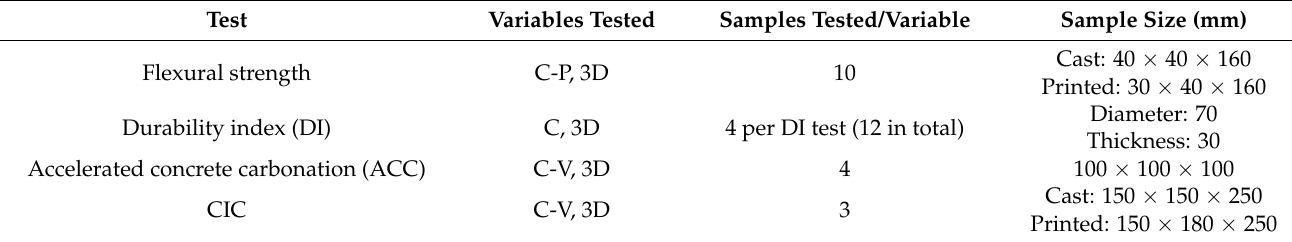
Table 1. Experimental variable testing, samples amounts and sizes summary.